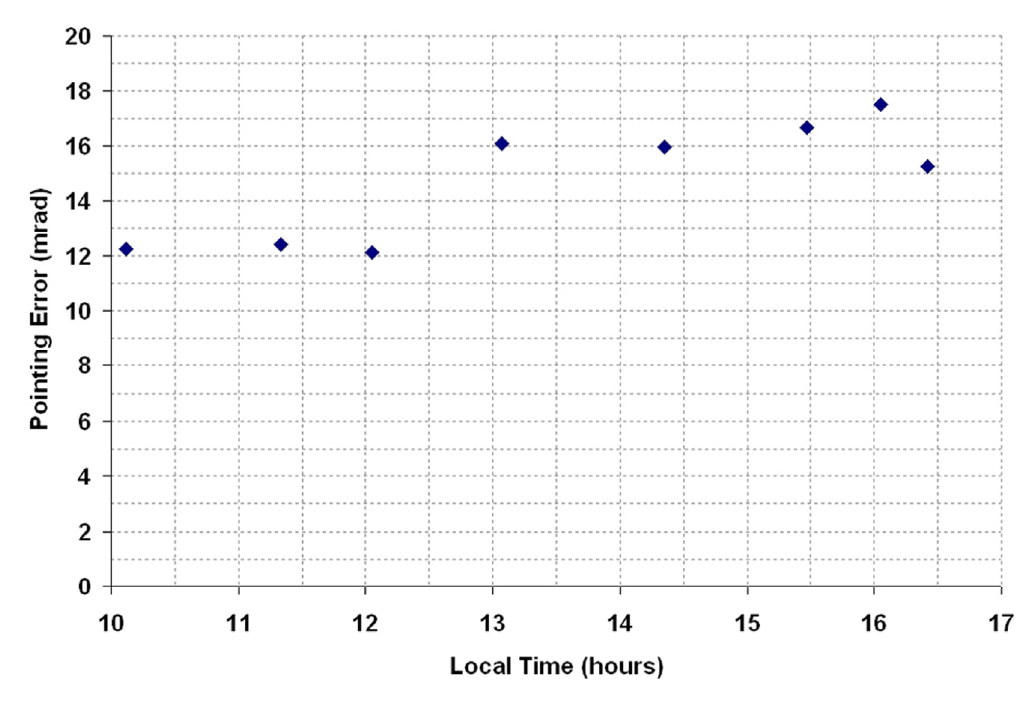
Figure 6. The plot of pointing error (mrad) versus local time (hours) for the parameters, i.e., φ = λ = ζ = 0°, on 13 January 2009.